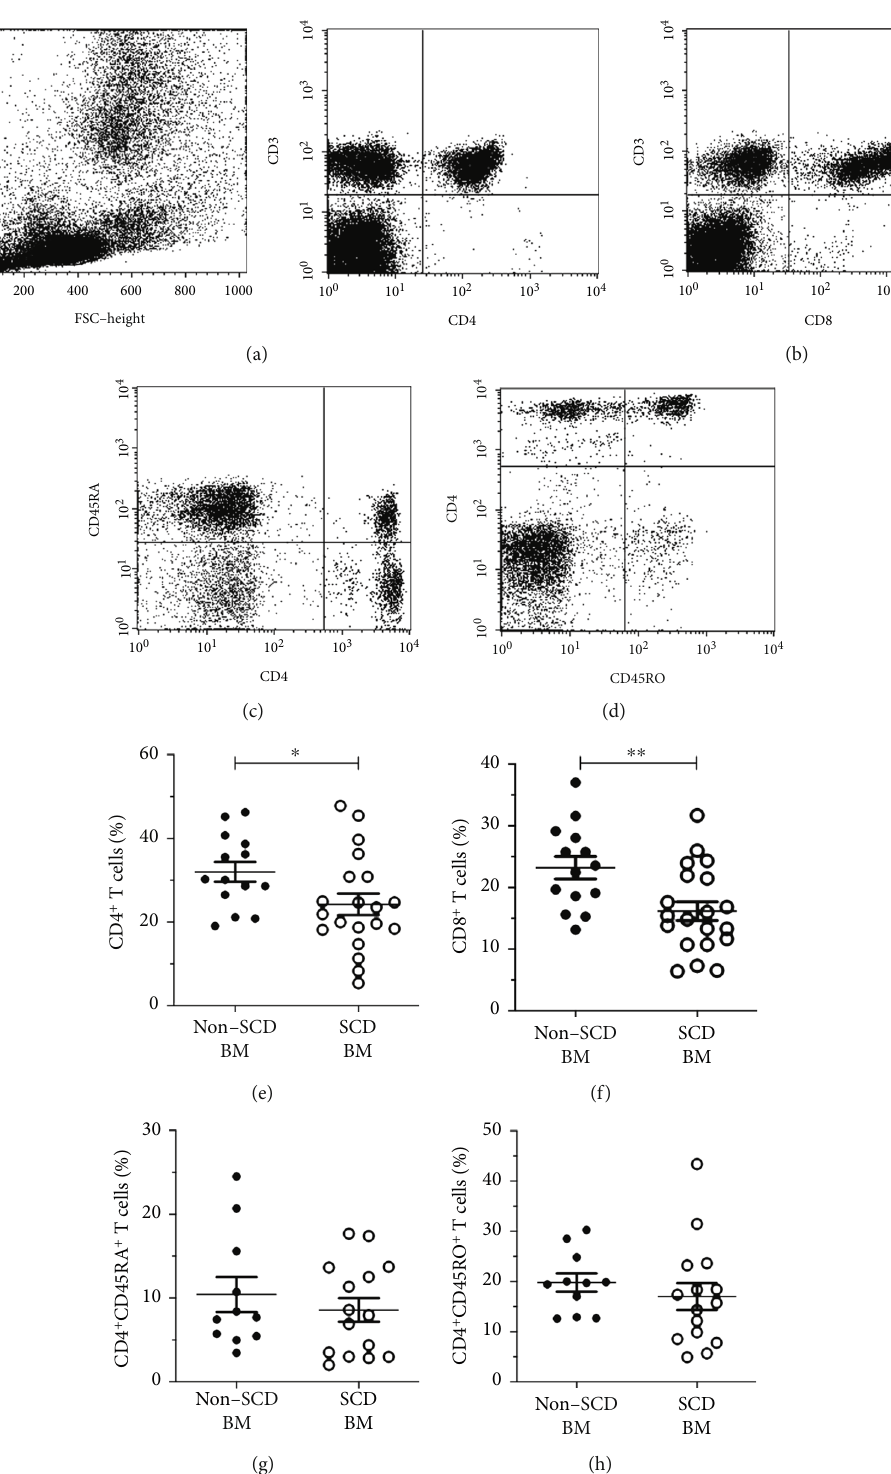
Figure 2: Relative frequency of major T cell populations in bone marrow mononuclear cells (BM-MNC) from SCD patients with osteonecrosis (SCD BM) and patients with osteonecrosis not related to SCD (non-SCD BM). Representative dot plots illustrate the strategy of gating for major T cell subsets de fi ned by CD3 + CD4 + (a), CD3 + CD8 + (b), CD4 + /45RA + (c), and TCD4 + /45RO + (d) surface expressions in BM-MNC. All gates were based on isotype-matched control staining. TCD4 + and TCD8 + cells are lower in SCD BM. Cumulative data showing the frequencies of total TCD4 + (e), total TCD8 + (f), TCD4 + CD45RA + (g), and TCD4 + CD45RO + (h) subpopulations within live-gated single cells. Each symbol represents an individual subject. Horizontal lines represent mean and standard error. ∗ p < 0 : 05 ; ∗∗ p < 0 : 005